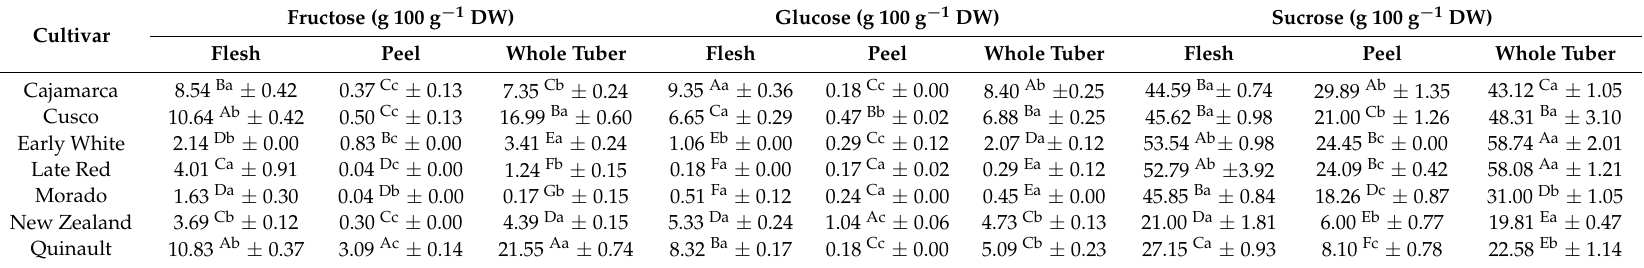
Table 3. Fructose, glucose, and sucrose content (g 100 g − 1 DW) in the flesh, peel, and whole tuber of different yacon cultivars.